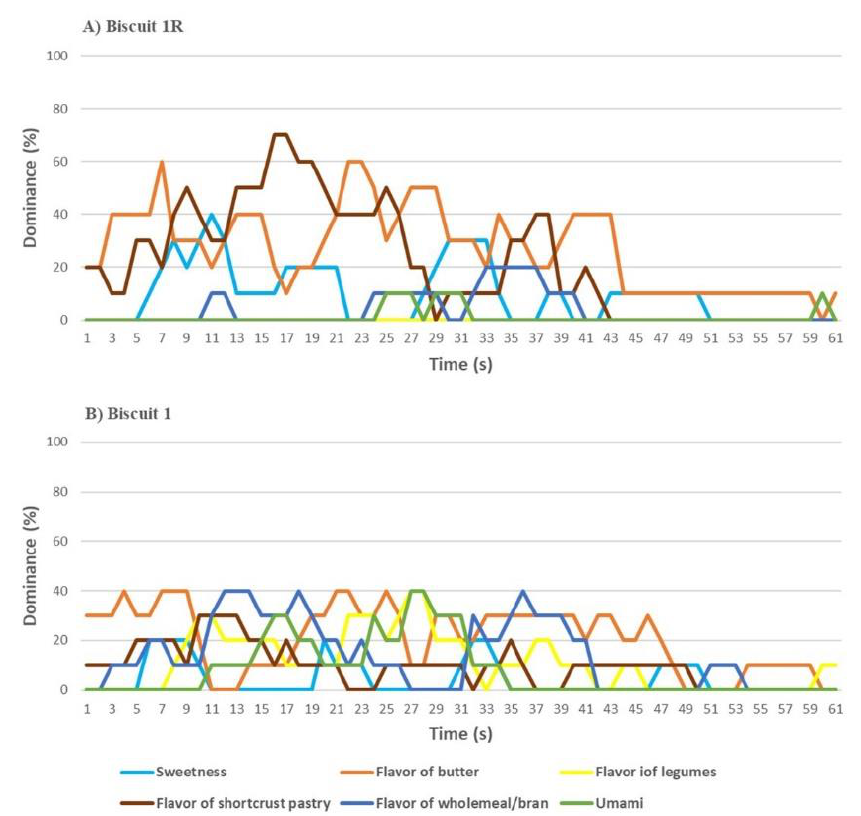
Figure 7. Temporal dominance of sensations (TDS) of ( A ) Biscuits 1R (reference, without common bean flour) and ( B ) Biscuit 1 (with 29% common bean flour).